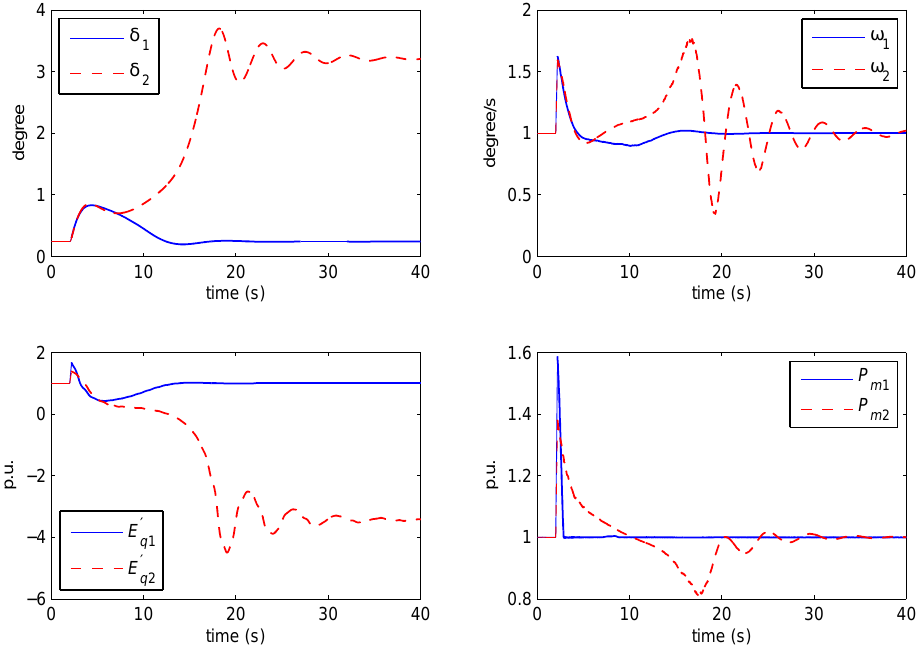
Figure 1. Swing curves of ( δ , ω , E (cid:48) q , P m ) under the controller (34) and the RAC,